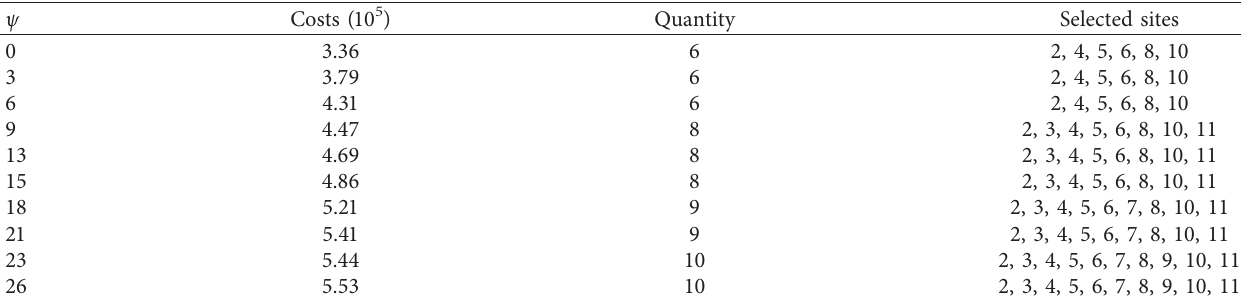
Table 7: Optimal scheme under MIRP-box